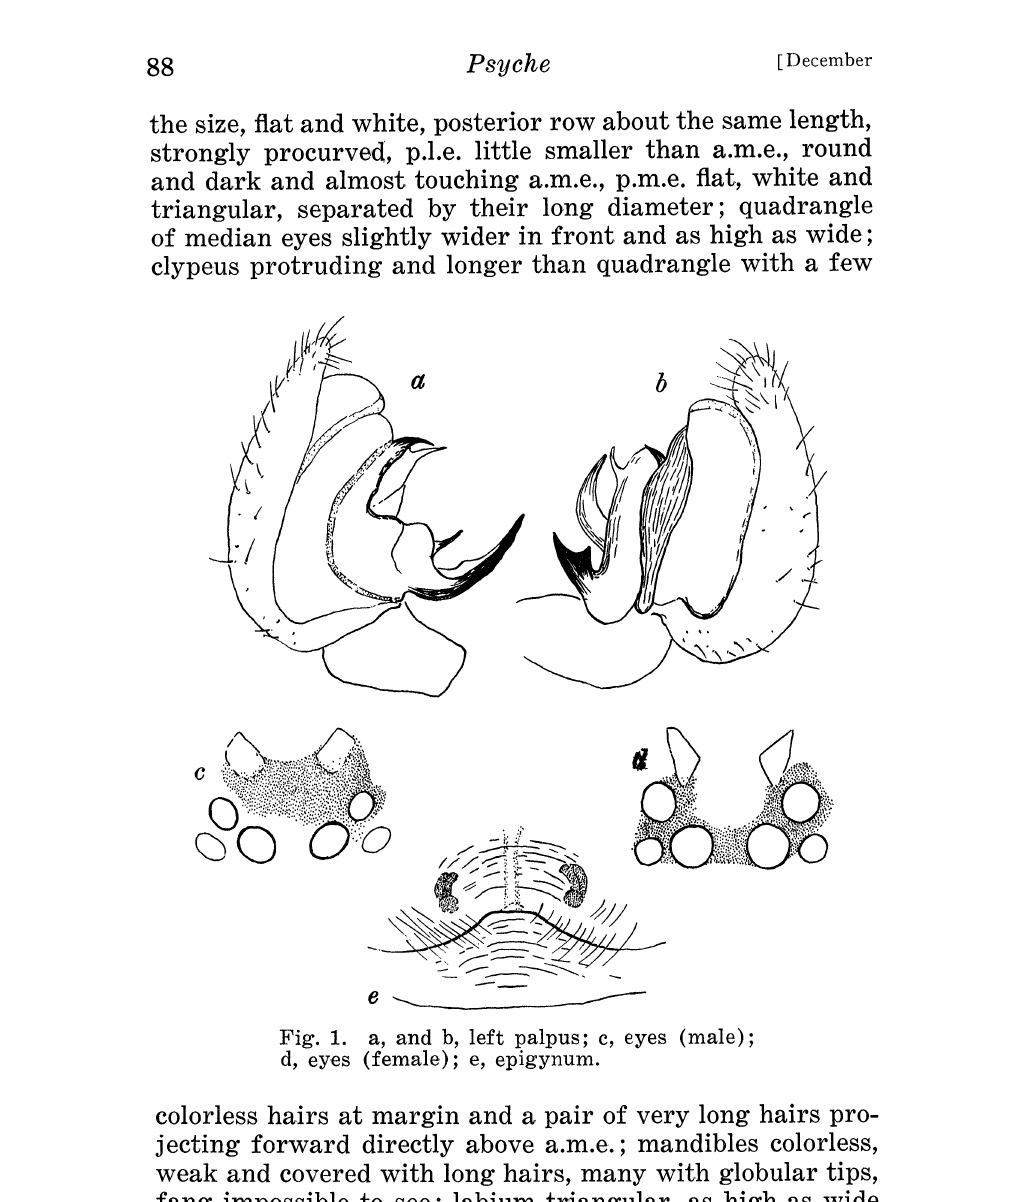
Fig. 1. a, and b, left palpus; c, eyes (male); d, eyes (female.); e,